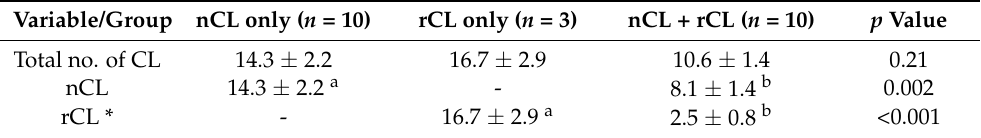
Table 3. Mean ( ± SEM) number of CL [total, normal (nCL) or regressing (rCL)] determined laparo- scopically on Day 15 (day of embryo recovery) of the superovulatory protocol in Santa In ê s ewes with nCL only, rCL only, or both nCL and rCL following the superovulatory regimen. Variable/Group nCL only ( n = 10) rCL only ( n = 3) nCL + rCL ( n = 10) p Value Total no. of CL 14.3 ± 2.2